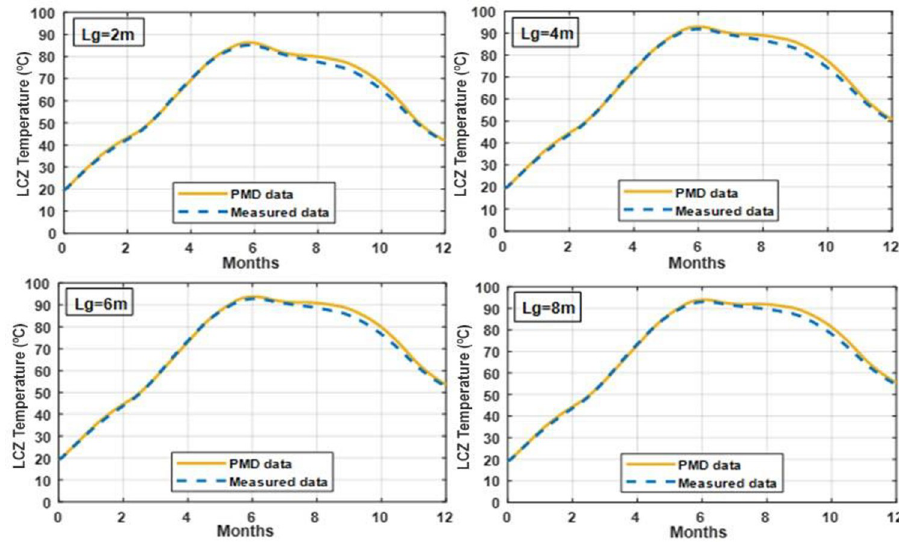
Fig 10. LCZ temperature with different depths of the water table under the solar pond for whole year simulation under PMD and measured climatic conditions of Islamabad.